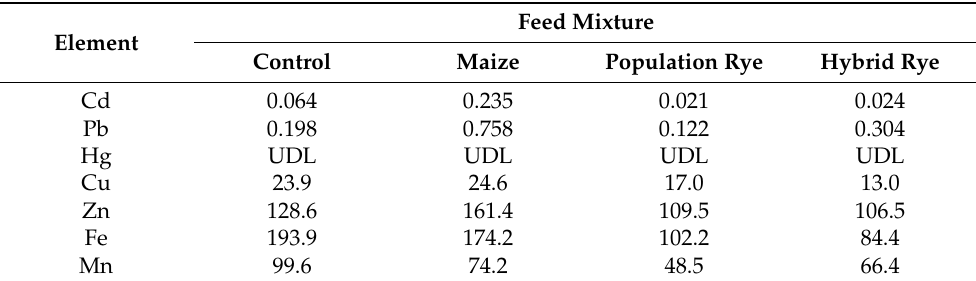
Table 4. The mean content of heavy metals (mg/kg) in grower mixtures, on a dry matter basis (b. wt.), used in control and experimental feeding of pigs.